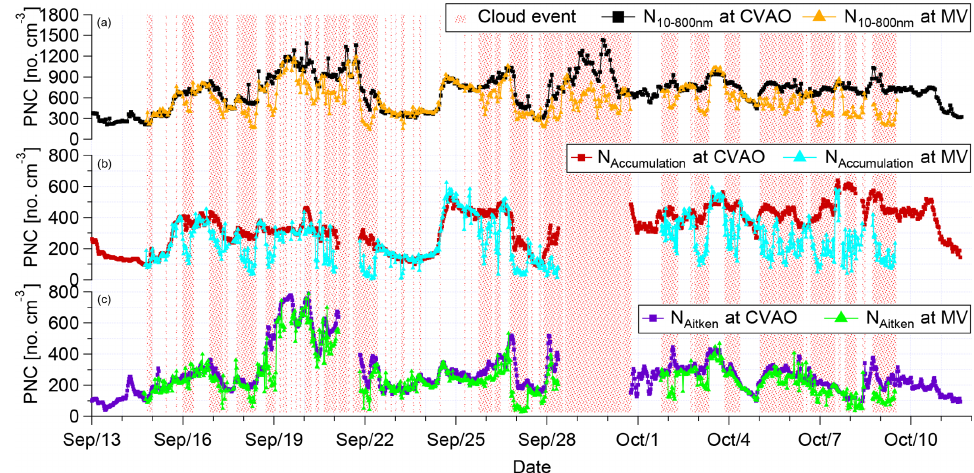
Figure 7. Time series of N CVAO in panel (c) . The times of cloud events are shown by red shading.